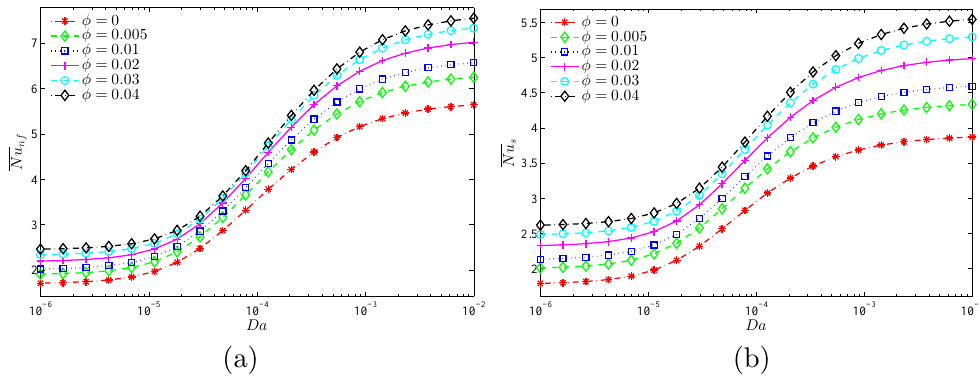
Figure 13. Variations of ( a ) the average Nusselt number of the nanofluid phase and ( b ) the average Nusselt number of the solid phase with Da values for different φ values at γ = 10, A = 0.1, and ε = 0.5.